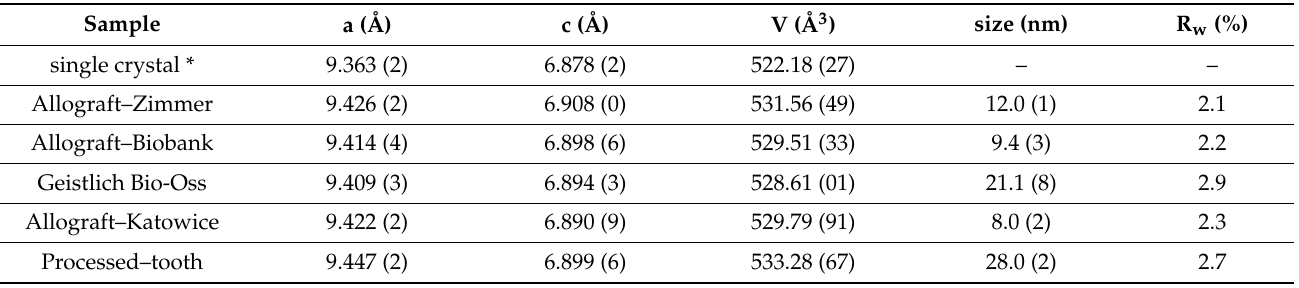
Table 2. Unit cell parameters (a,c), cell volume (V), grain size, as well as refine factor (R W ) for the bone grafting